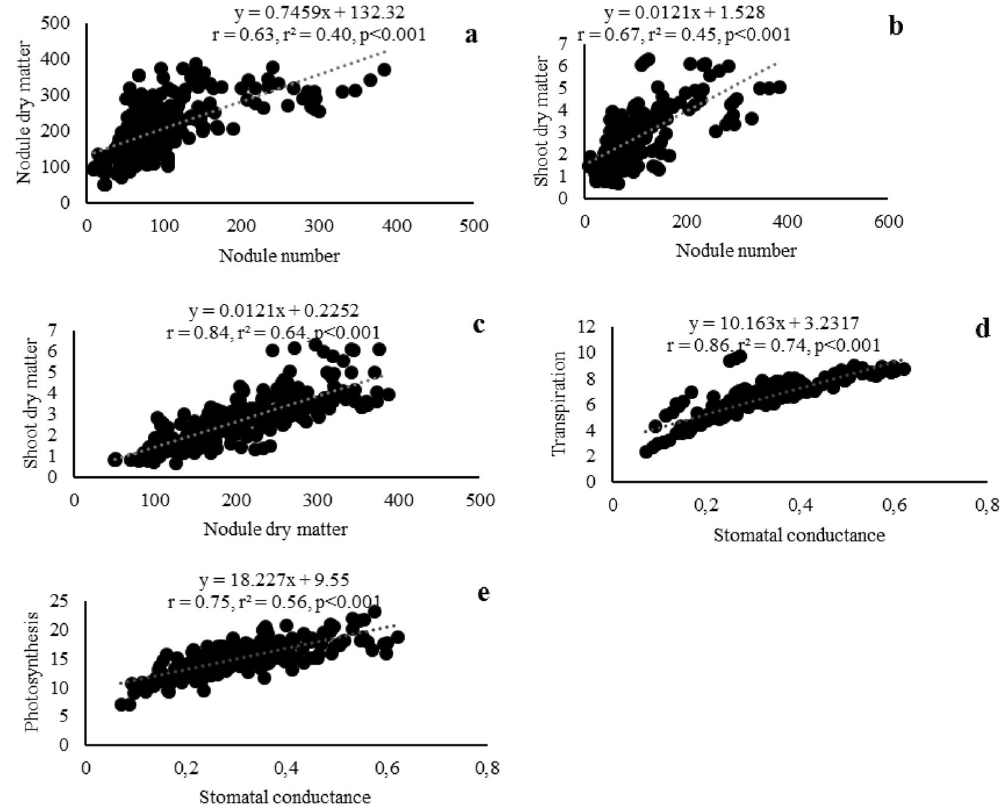
Figure 8. Correlation and regression analysis between ( a ) nodule number and nodule DM, ( b ) nodule number and shoot DM, ( c ) nodule DM and shoot DM, ( d ) stomatal conductance and transpiration and ( e ) stomatal conductance and